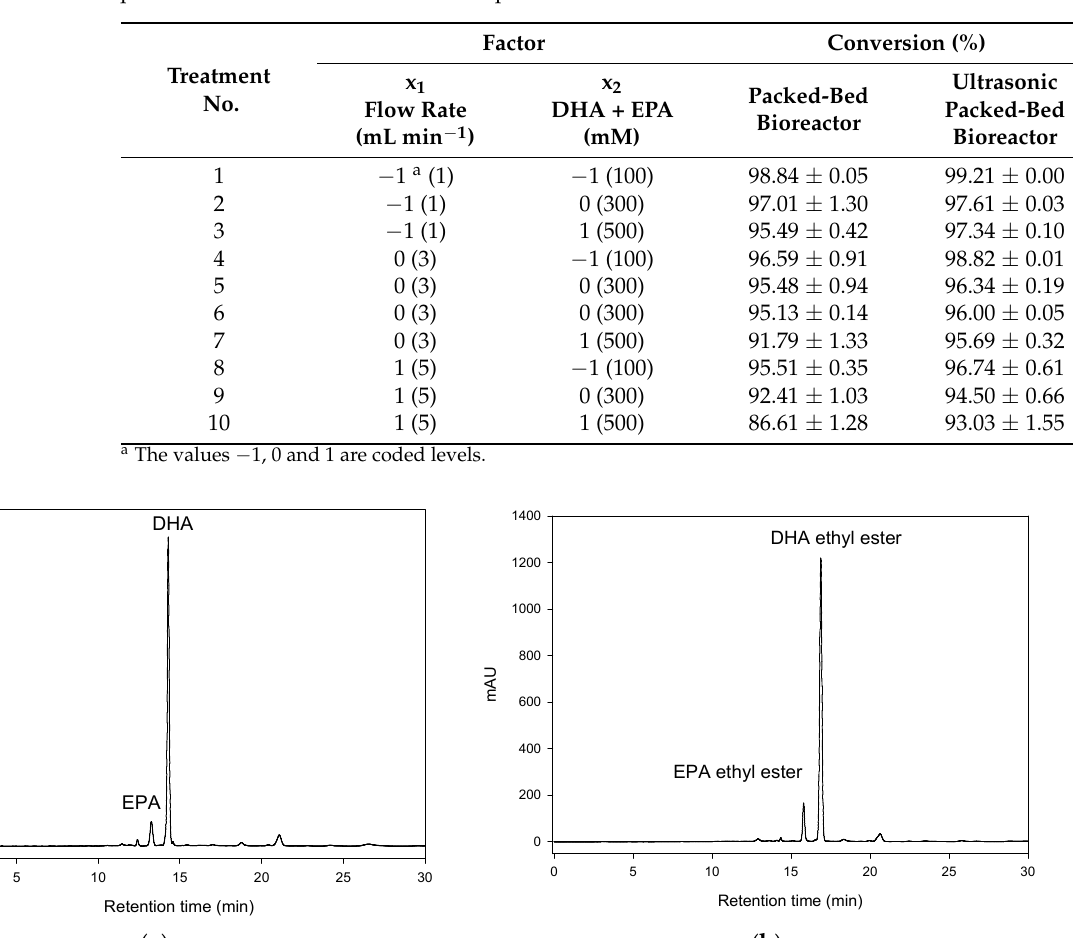
Table 1. Central composite design and experimental conversion of DHA + EPA ethyl ester from the packed-bed bioreactor and ultrasonic packed-bed bioreactor.